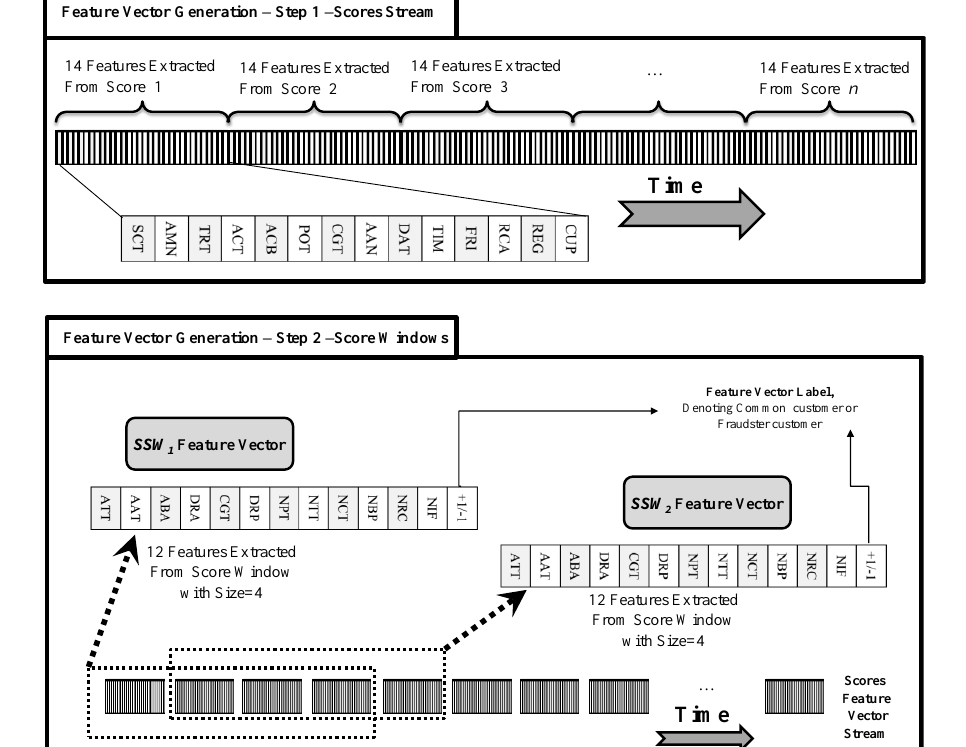
Figure 3. A Sample of SSW feature vectors with size equal to 4.